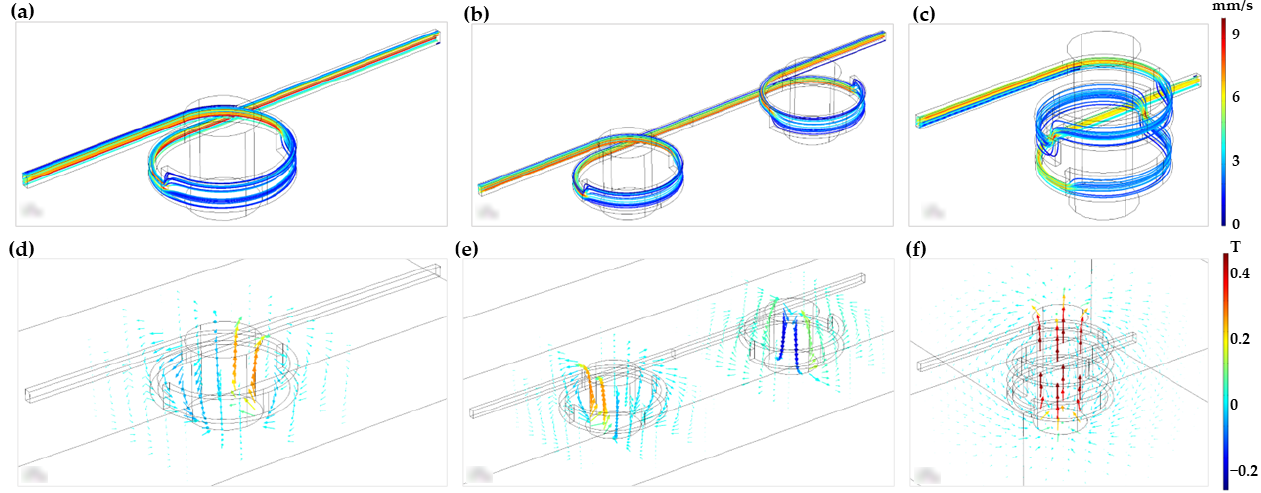
Figure 5. ( a ) Velocity profile of one-loop microreactor. ( b ) Velocity profile of two-horizontal-loop microreactor. ( c ) Velocity profile of two-vertical − loop microreactor. ( d ) Magnetic field flux of one- loop microreactor. ( e ) Magnetic field flux of two-horizontal-loop microreactor. ( f ) Magnetic field flux of two-vertical-loop microreactor.